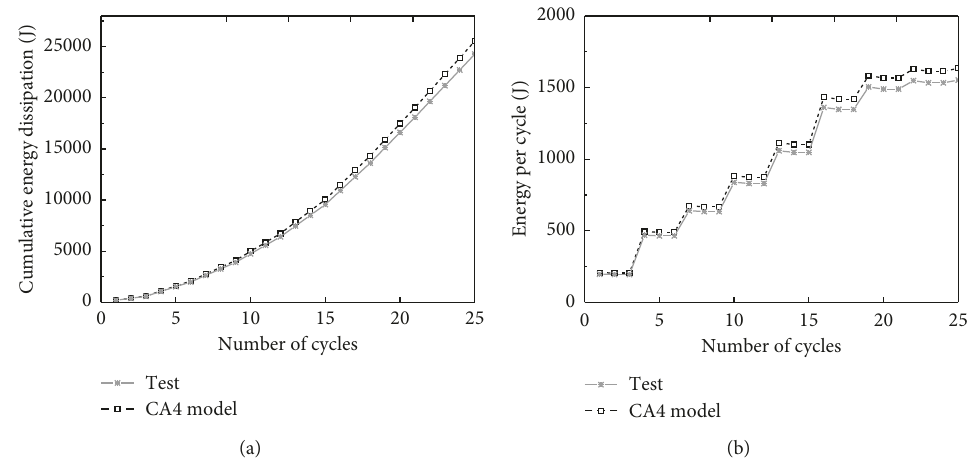
Figure 8: Comparison of experimental and numerical results: (a) cumulative energy dissipation and (b) energy per cycles.